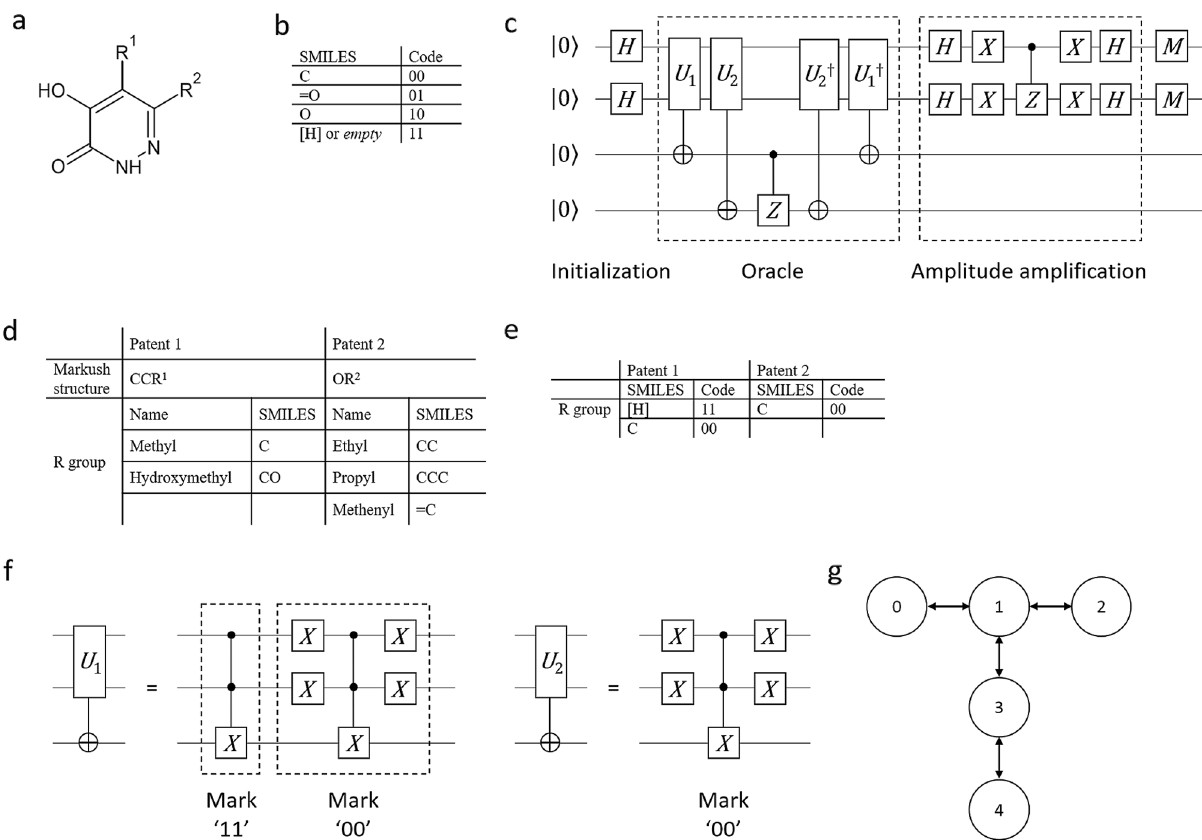
Figure 1. ( a ) The Markush structure of the TAK-831 patent claim. The R group in the structure claim can be defined in a nested manner. In the TAK-831 case, the compounds defined by the Markush structure are infeasible to enumerate. ( b ) The code table to change SMILES symbols into binary quantum states. We used two bits to code a symbol in SMILES notation. An additional code for an empty symbol is introduced to encode the compounds with short SMILES notation. ( c ) The quantum circuit in the 2-data qubit experiment. In the defined case, the Grover iteration only needs to be executed one time. ( d ) The two sets of R groups from two patents to be compared. We use R1 and R2 to denote the variable R groups of the Markush structure in the two patents. R1 has two variable compounds for the R group, and R2 has three variable compounds for the R group. ( e ) The R groups from two patents to be compared using two data qubits. In this simple case, we assume that the core structures of the two patents are the same, and we need to compare only the variate substructures in the R groups. ( f ) The unitary gates used in the 2-data qubit experiment. One of the patent oracles defines two targets 11 and 00 by two MCX gates. The other patent oracle defines only one target by the quantum state 00. ( g ) The layout of ibmq_vigo. The circles indicate qubits along with their ID numbers. The arrows show the connectivity of the quantum computer. Qubit 1, in this case, has the largest connectivity among the